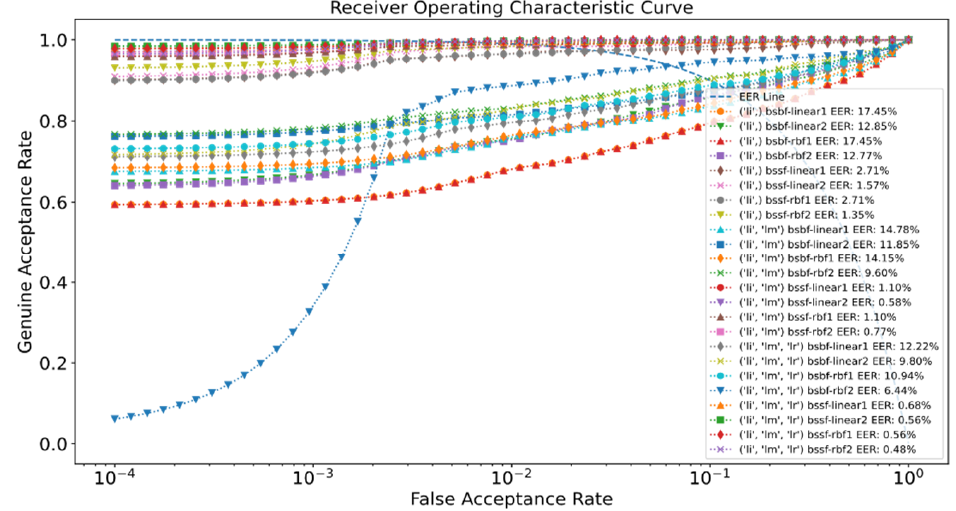
Figure 7. ROC curve of the proposed system for SDUMLA-HMT. Table 2. Experimental results of the proposed system for UTFVP.